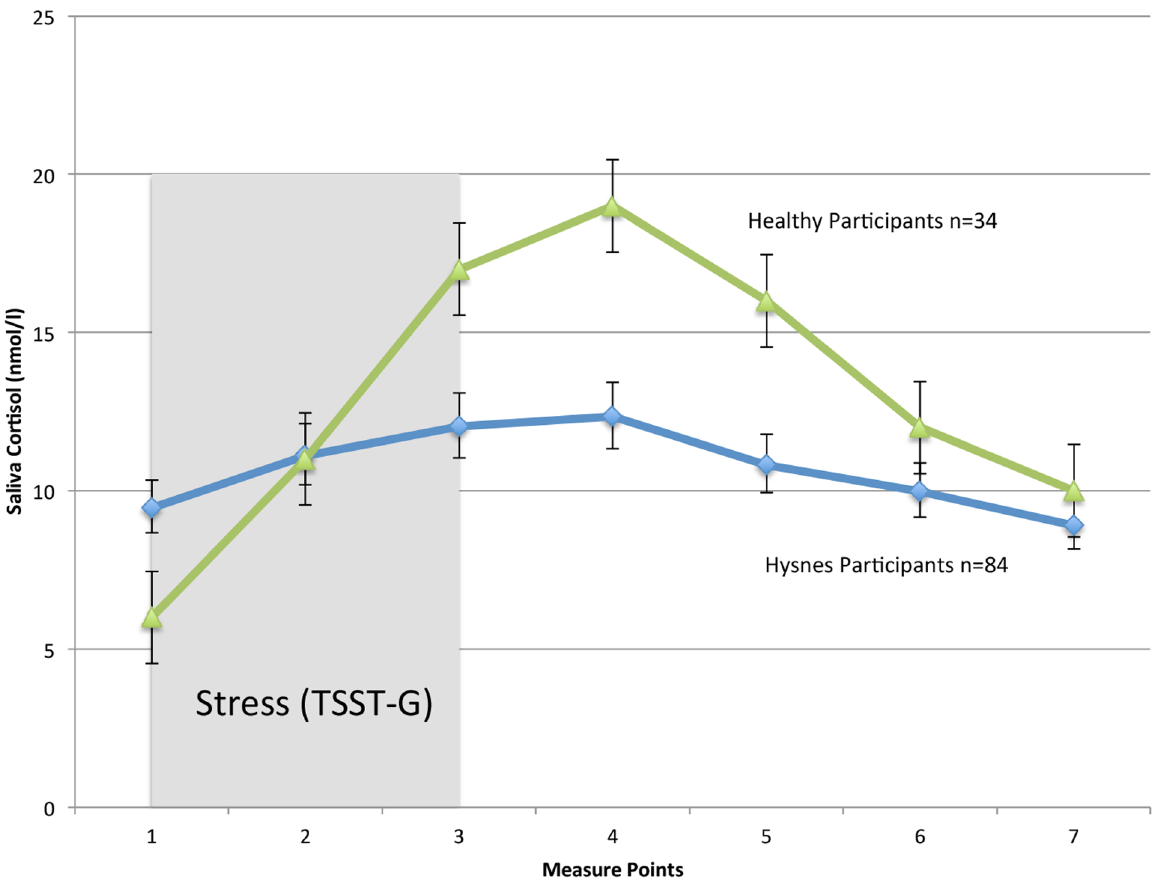
Figure 2. Cortisol responses to a standardized psychosocial stress test (TSST-G) in participants on long-term sick leave attending Hysnes Rehabilitation Center (n=84) and healthy subjects (n=34) adapted from von Dawans et al [24] (licensed reuse by Elsevier, license number: 3175410277640) exposed to identical experimental procedures (TSST-G). The gray bar represents the TSST-G exposure phase, and error bars represent 95% confidence intervals.